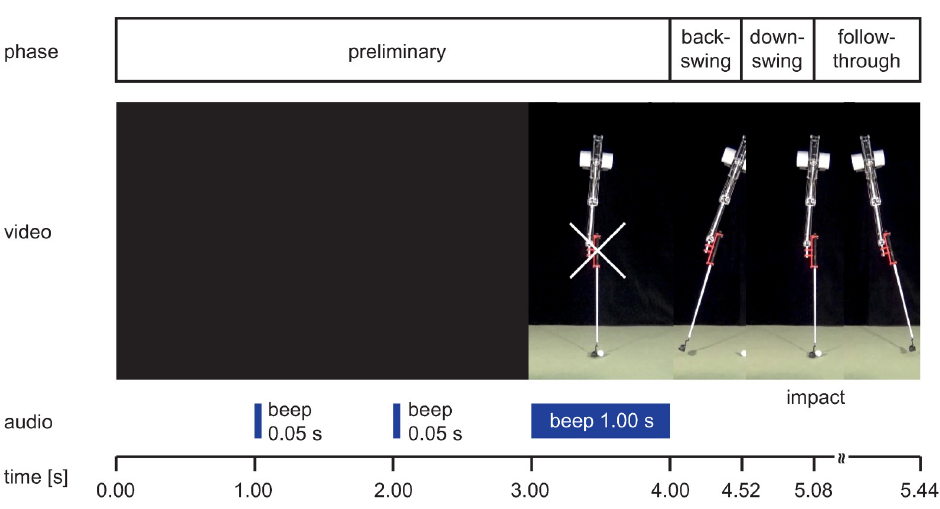
Fig 4. Video sequence in the full vision condition. Sequential presentation of a 2.0 m putt video in full vision condition with information about swing phase, audio signals and timing (video sequence see S1 Video).